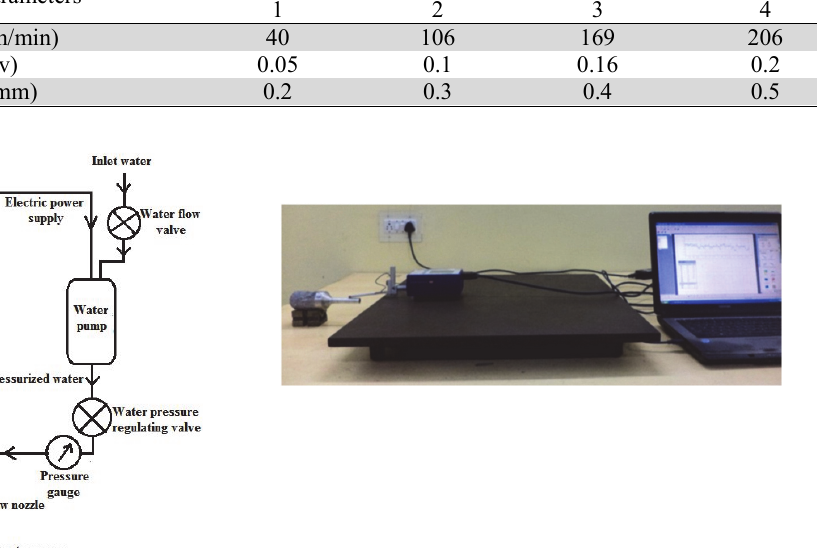
Machining process parameters along with their levels